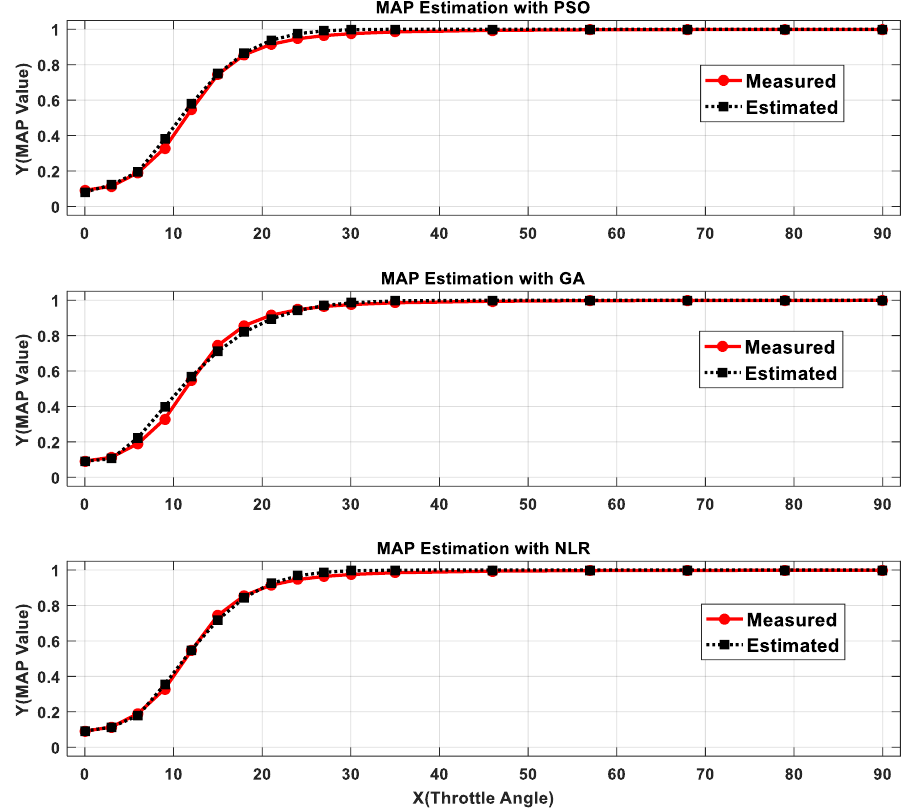
Figure 4. Estimated MAP values with PSO, GA, and NLR.